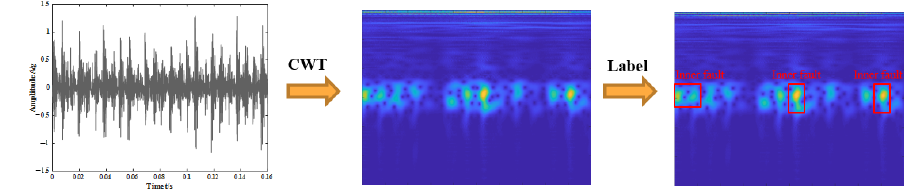
Figure 1. The process of sample